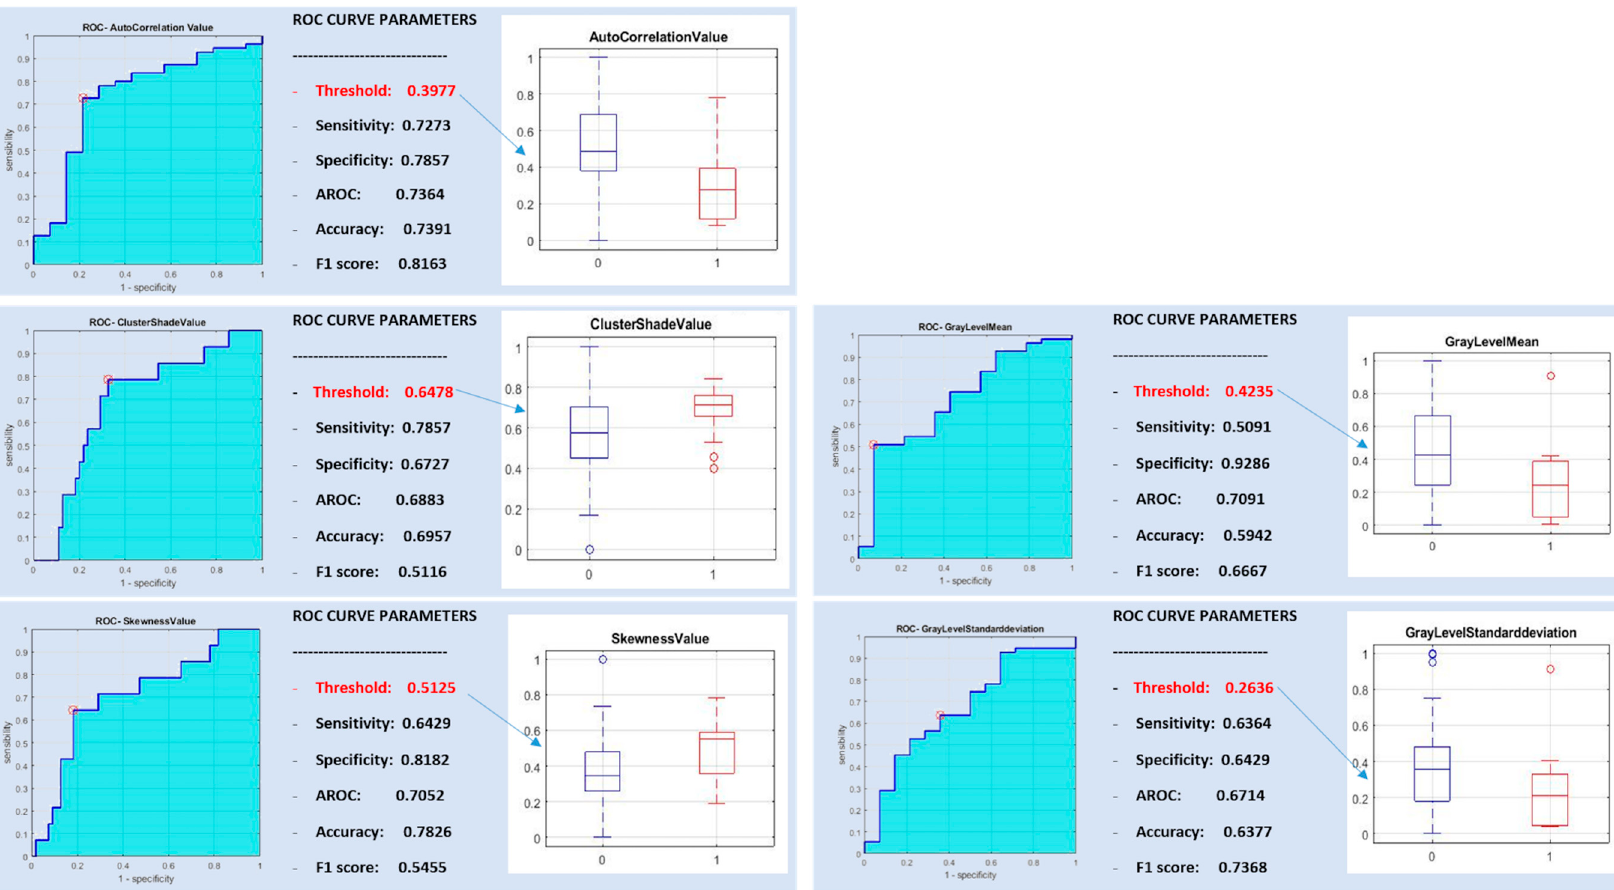
Figure 2. Receiver operating characteristics (ROC) curve analysis for benign versus malignant parotid tumors.